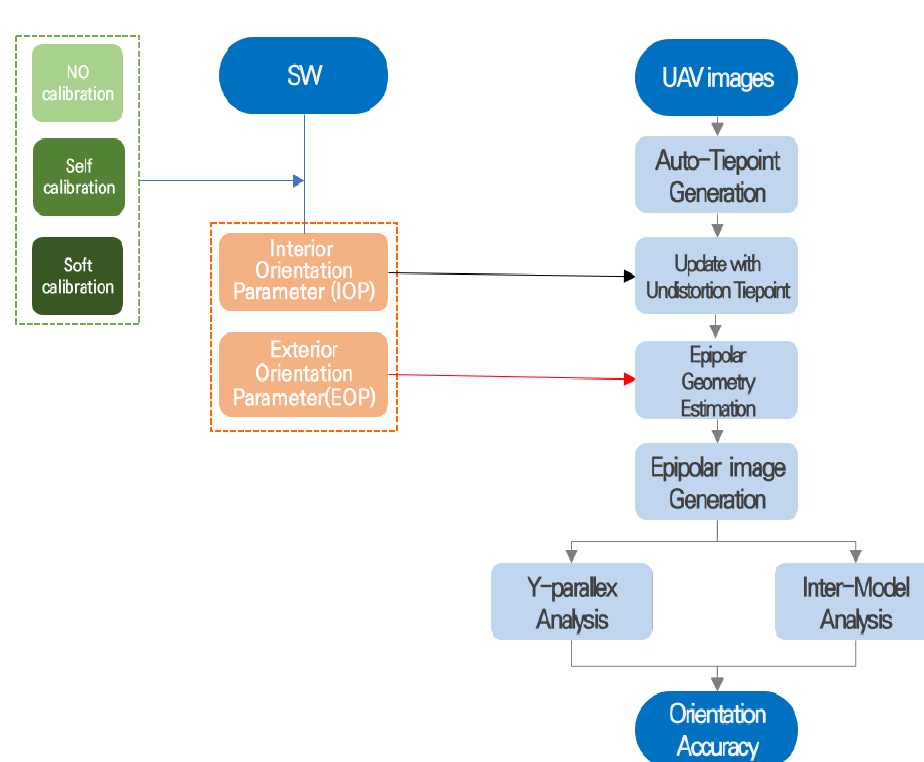
Figure 5. Analysis software process for orientation